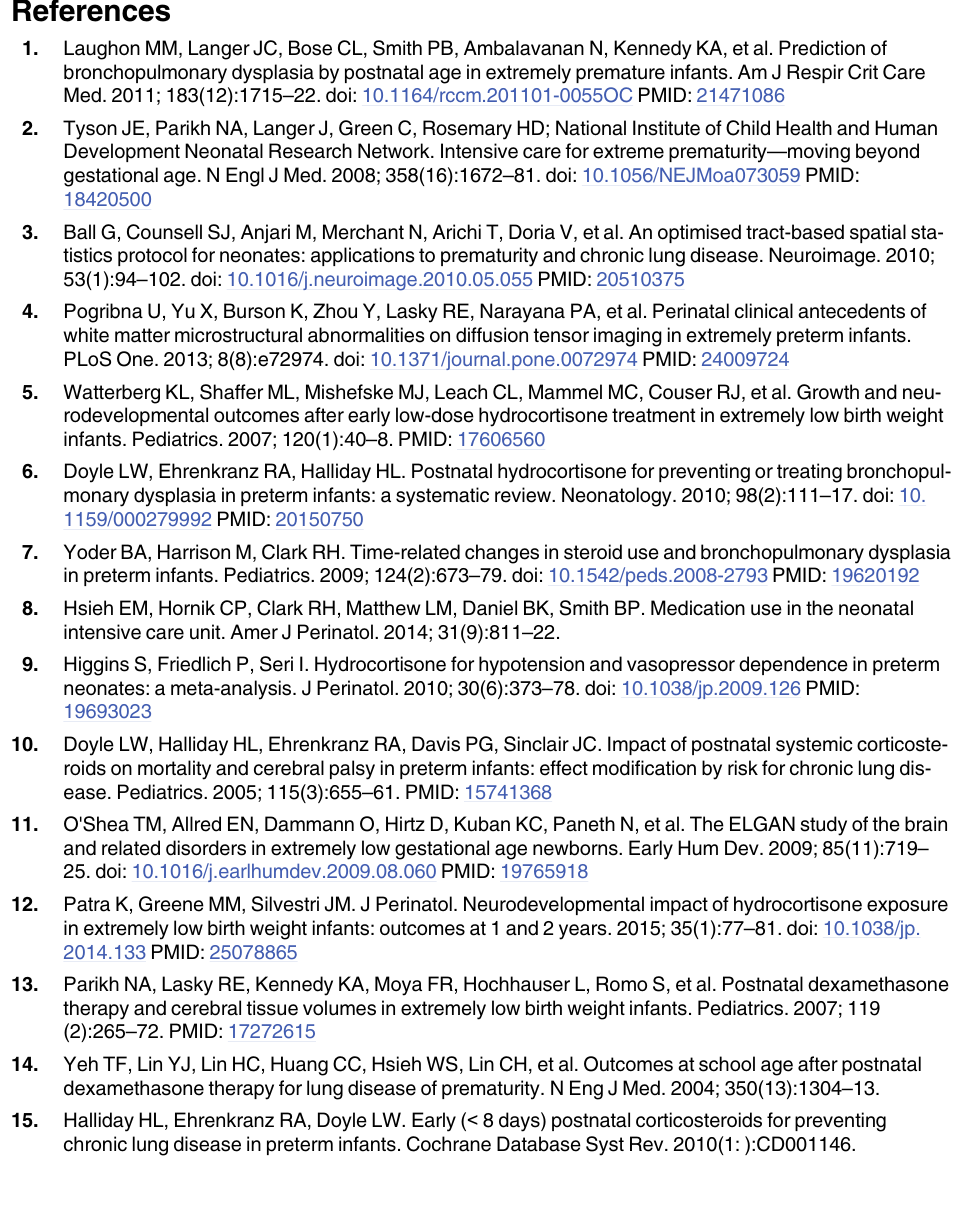
S1 Protocol. Trial protocol. Hydrocortisone Trial Study